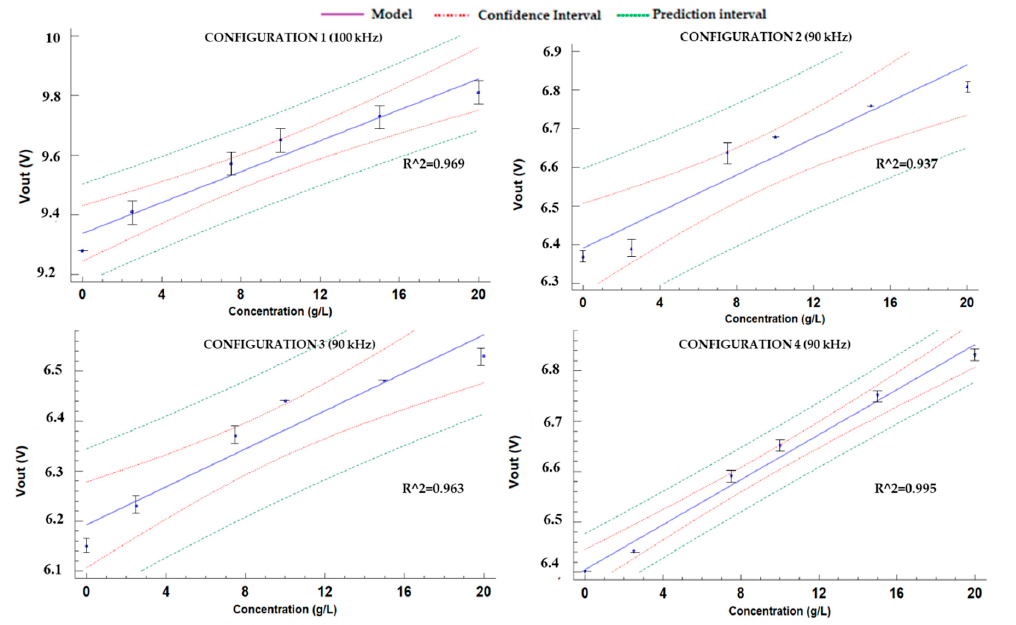
Figure 10. Adjusted models of P1.